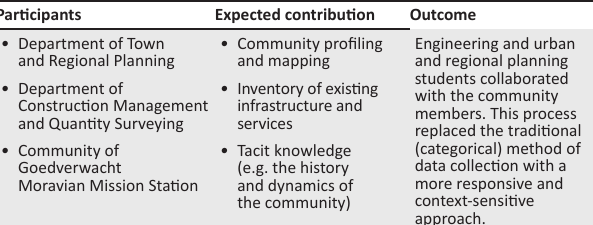
TABLE 1: Number of students involved in the Goedverwacht project between 2014 and 2018. Faculty